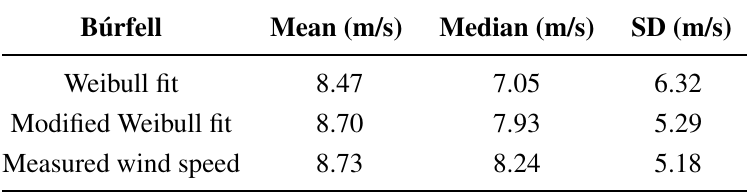
Figure 7. Probability density function (PDF) of the modified Weibull simulated wind speed at Búrfell. Table 6. Measured wind speed data vs. Weibull fit for wind speed at Búrfell at a 55-m